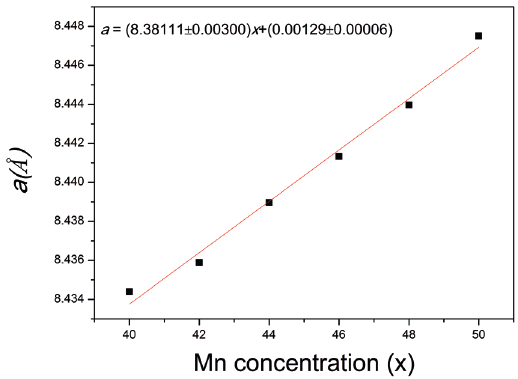
Figure 3: Lattice parameter as function of Mn-concentration for ferrites (0.40 < x < 0.50). replacing ion. In the case we are replacing Mn 2+ ion with Cu 2+ ion. The lattice parameter is found to rise, which may be attributed to shifting on some Fe 3+ ions form A site to B site for higher composition 16 . The lattice parameters found are between a = 8.41 Å and a = 8.50 Å for copper and manganese ferrites, respectively. The value of the lattice parameter obtained for the all samples is in good agreement with reported in literature 14